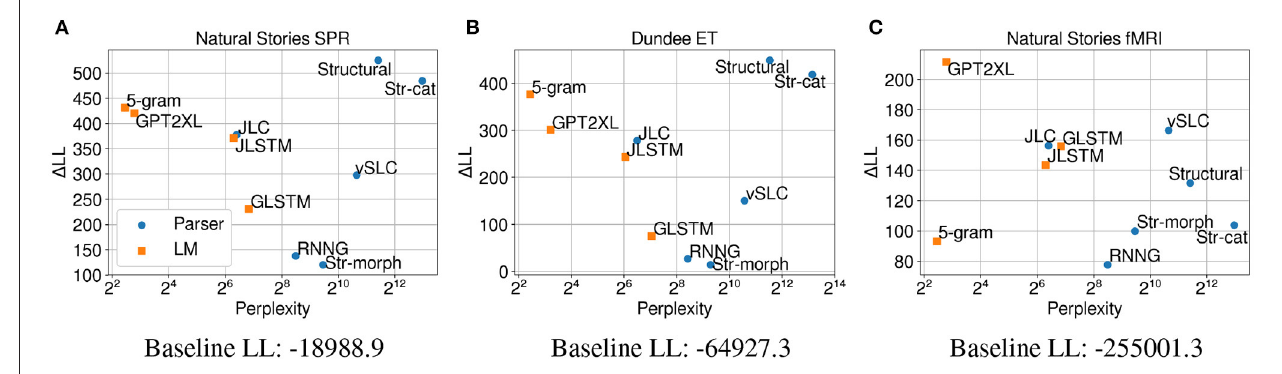
FIGURE 3 | Perplexity measures from each model, and improvements in LMER (A,B) and CDR (C) model log-likelihood from including each surprisal estimate on (A) Natural Stories self-paced reading data, (B) Dundee eye-tracking data, and (C) Natural Stories fMRI data. The difference in by-item squared error between the Structural and GPT2XL models is significant at p < 0.05 level for all three